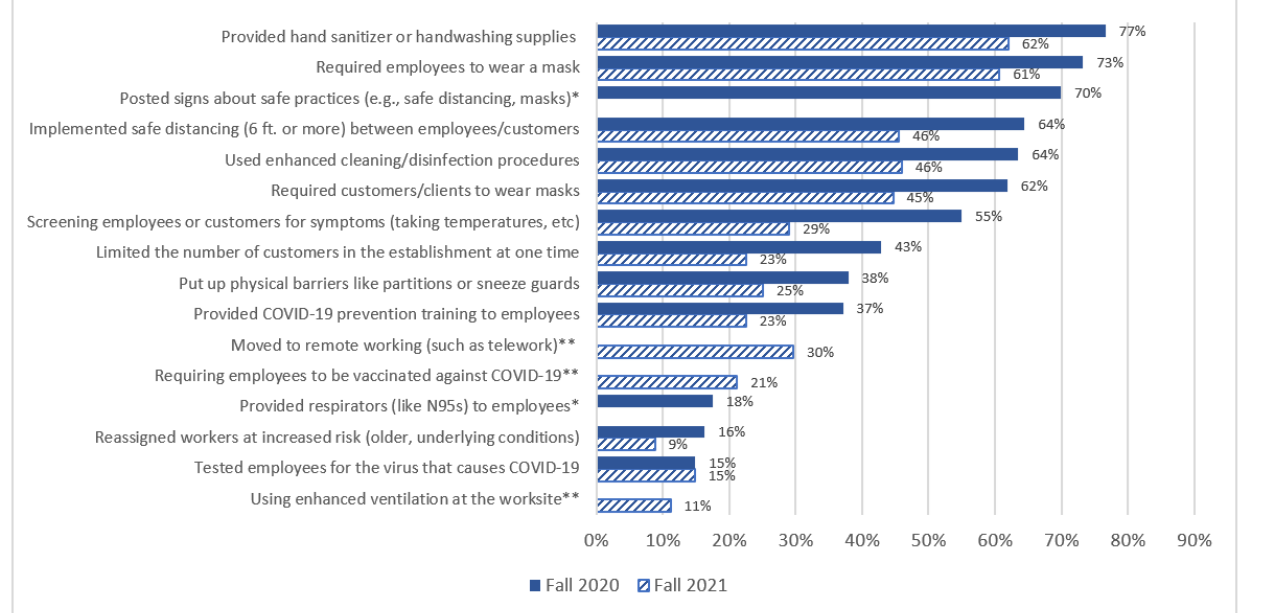
Figure 1. Respondent reported COVID-19 workplace mitigation strategies, fall 2020 and fall 2021 . * Only asked in fall 2020; ** only asked in fall 2021